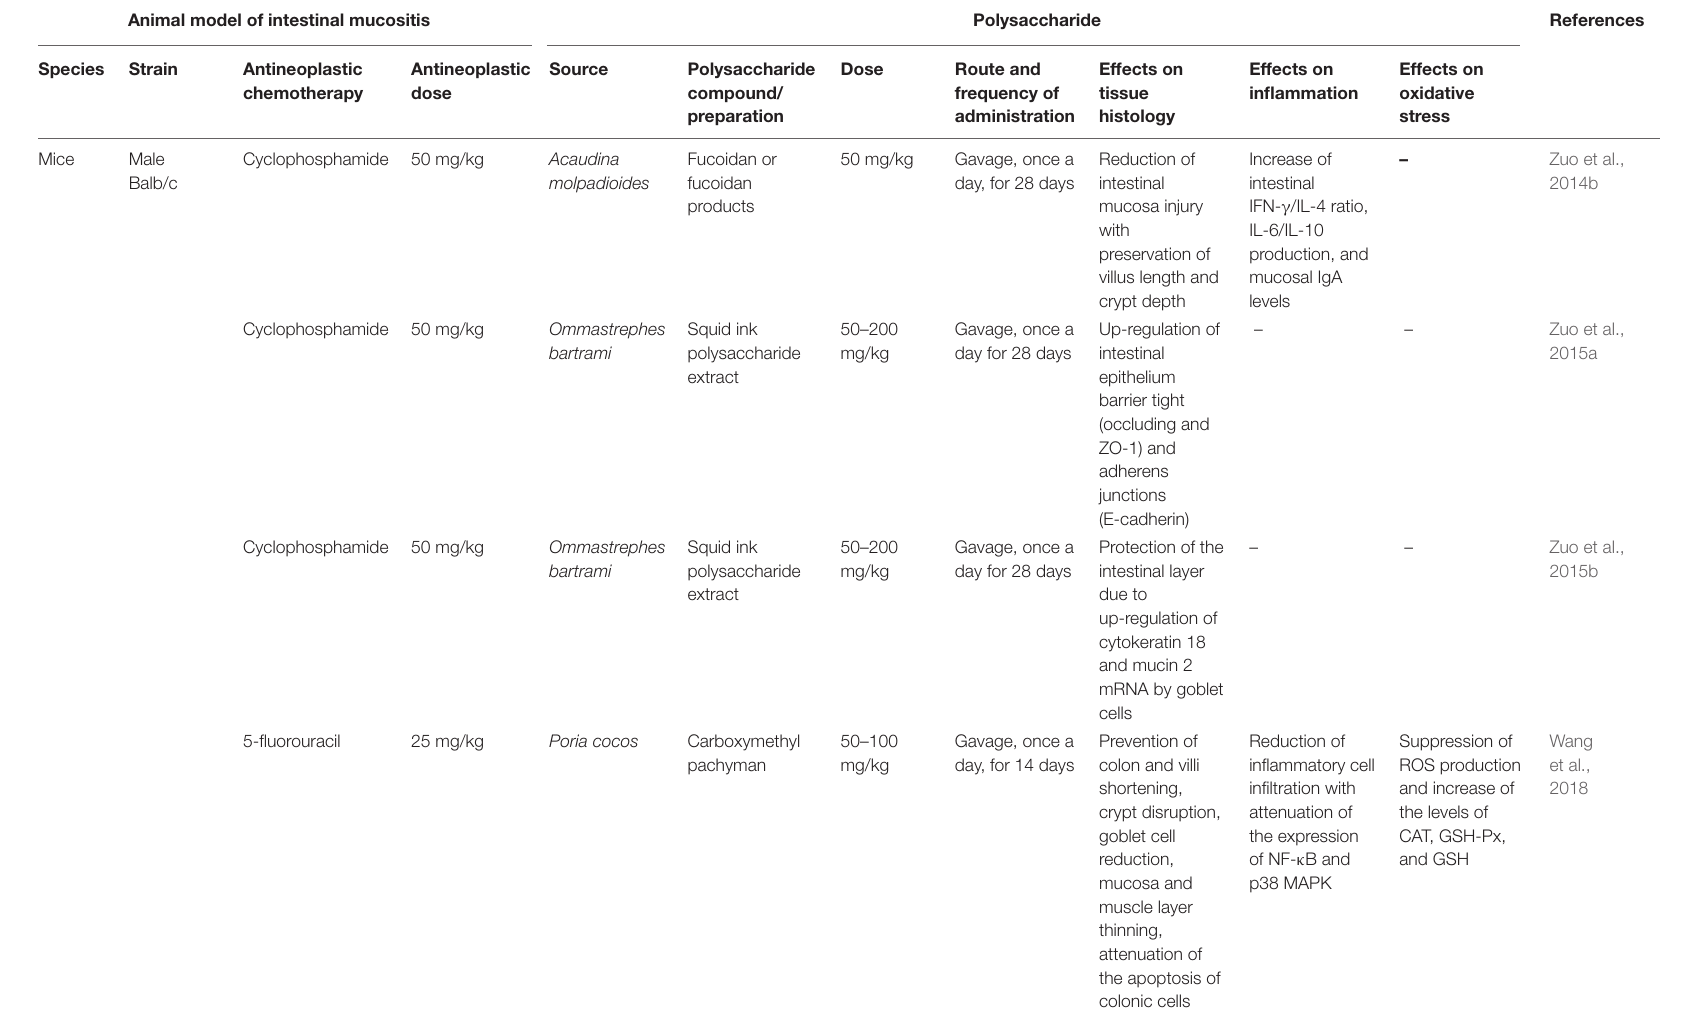
TABLE 1 | In vivo effects of natural polysaccharides on chemotherapy-induced intestinal